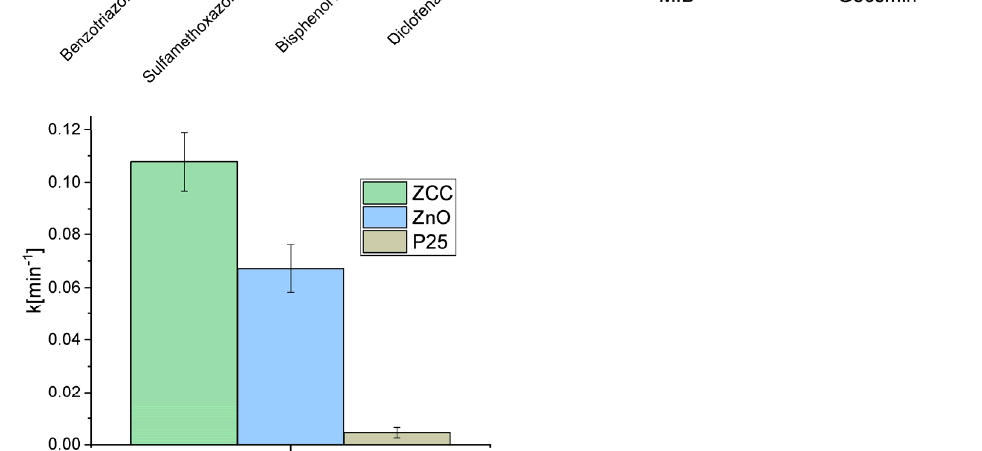
Figure 7. Comparison between the kinetic constants obtained using ZCC, ZnO and P25 for the abatement of the mixture of Hg(II), CECs, MIB and geosmin in aquaculture water.